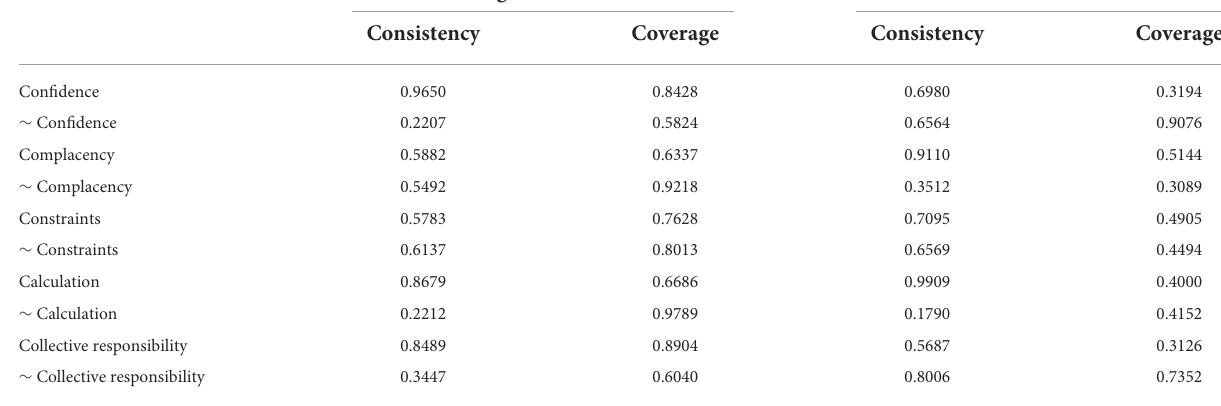
TABLE 4 Analysis of necessary